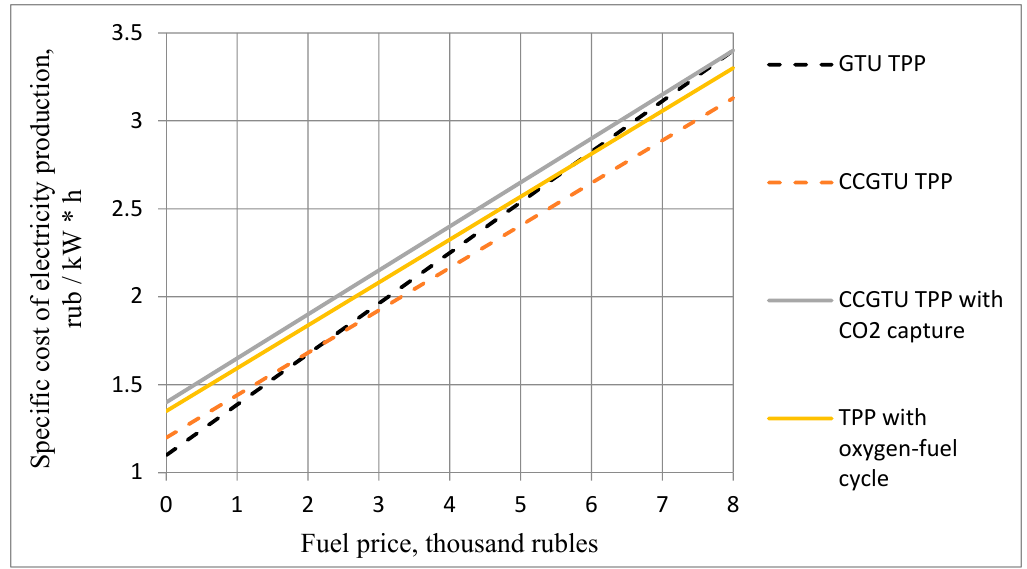
Figure 4. The dependence of the unit cost of electricity production on the price of fuel during the conventional and oxygen combustion.